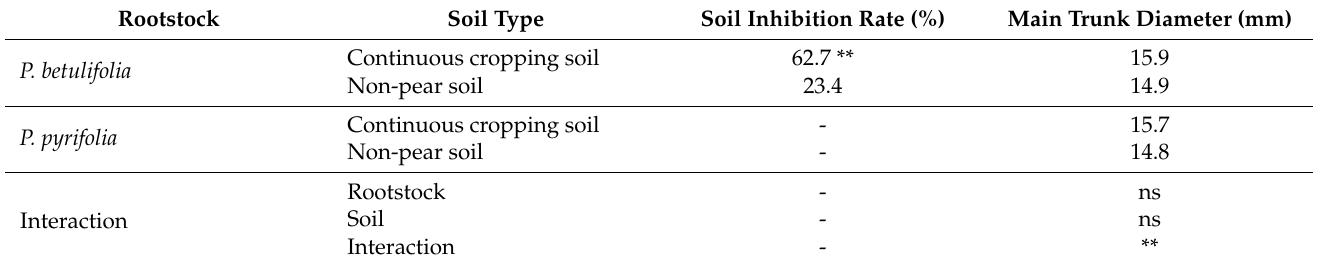
Table 5. Soil inhibition rate at the time of planting and main trunk diameter of Japanese pear saplings.